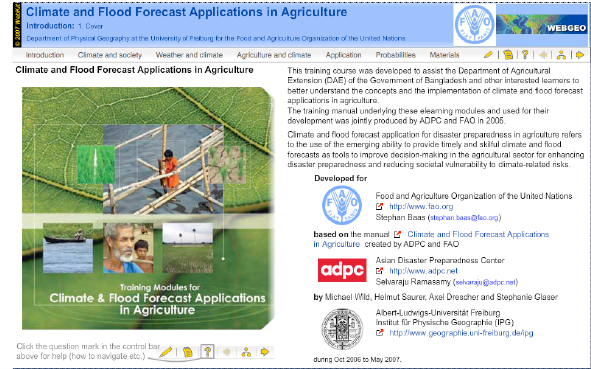
Figure 4: WEBGEO